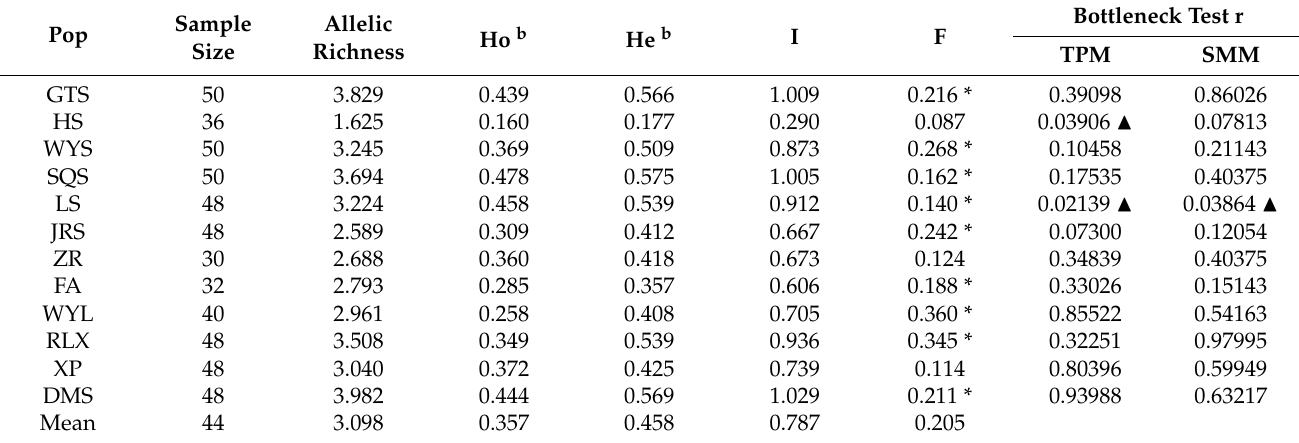
Table 2. Genotypic variation and heterozygosity statistics of 16 loci of C. chekiangoleosa .